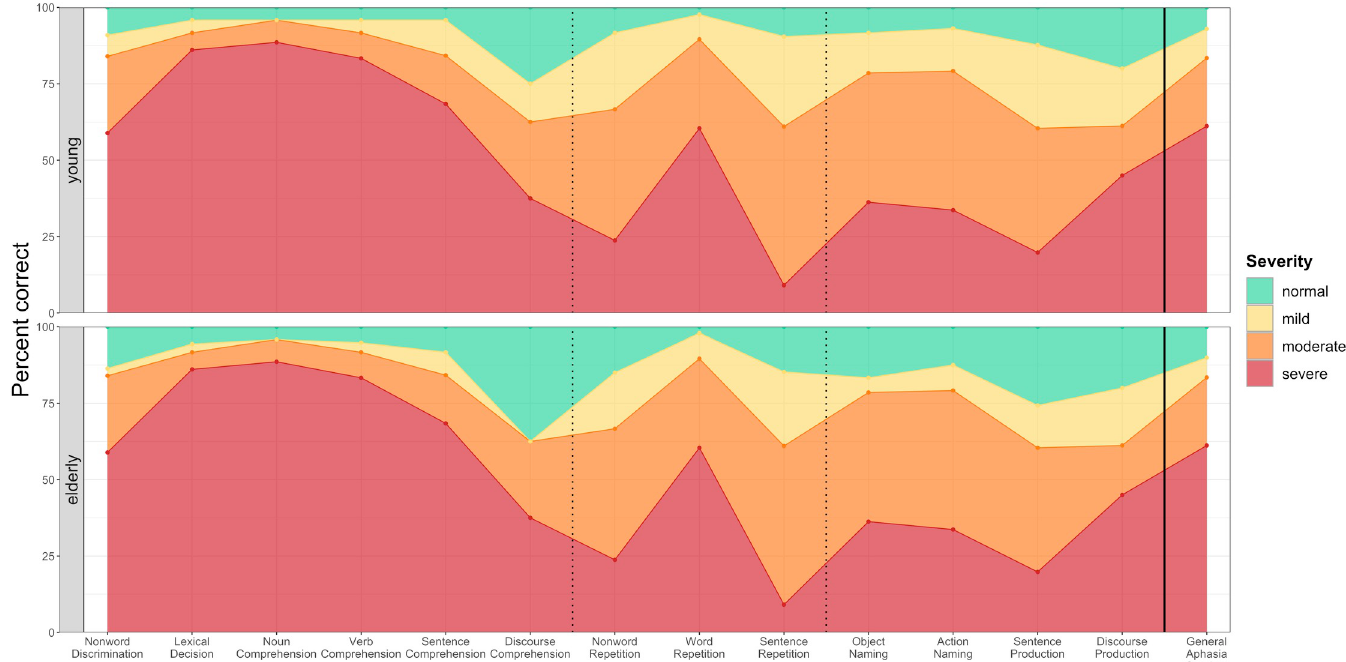
Fig 3. Severity ranks for subtest accuracy scores and the General Aphasia Quotient (GAQ) for the two PWA age cohorts.